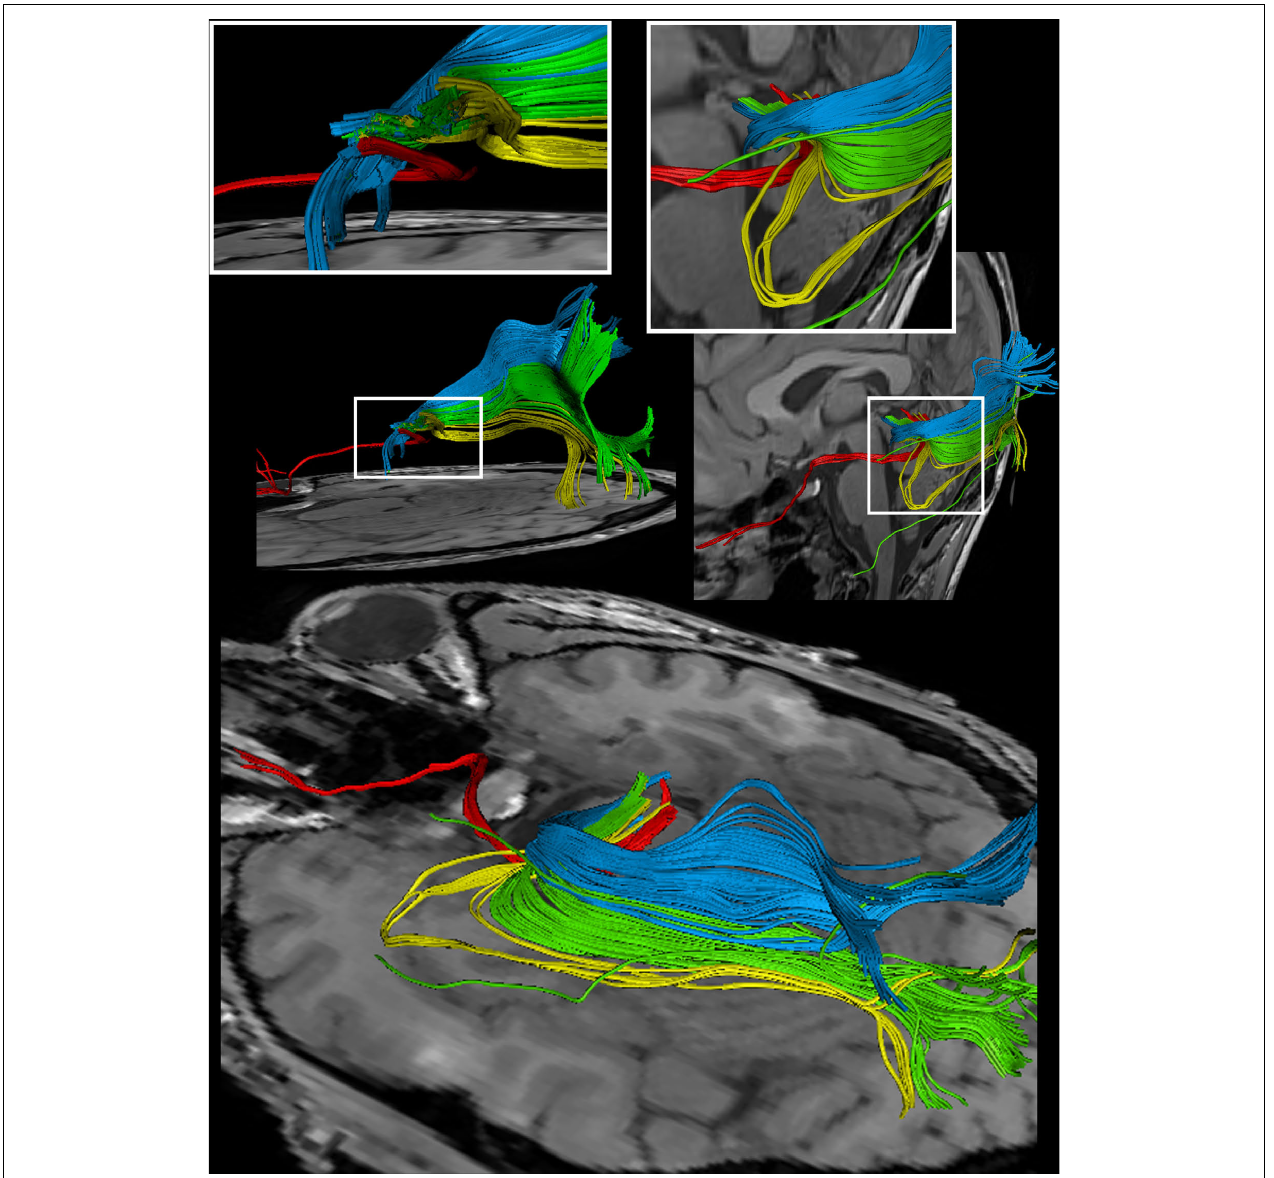
FIGURE 6 | Reconstructions of the optic nerve and tract (red), Meyer’s loop (yellow), central bundle (green), and dorsal bundle (blue) in different views. (White boxes) Magnifi cations of the area around the LGN. (Upper left) Fiber bundles of the right hemisphere. (Upper right and bottom) Fiber bundles of the left